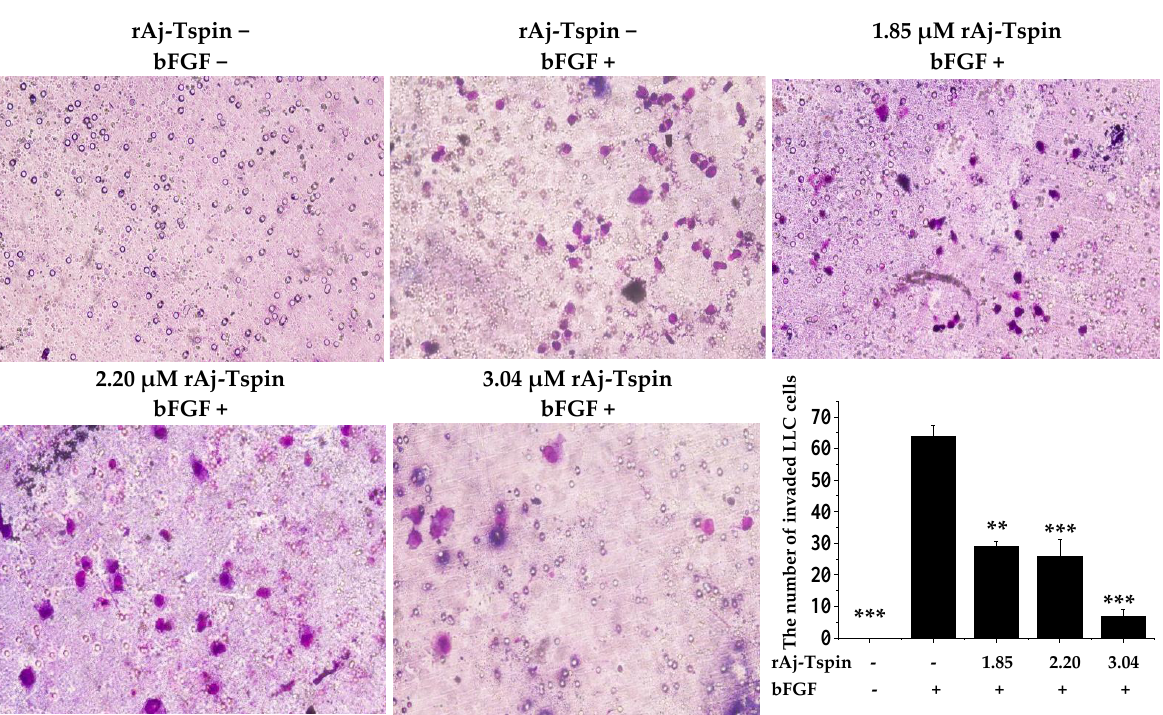
Figure 11. rAj-Tspin inhibited the invasion of LLC cells (OLYMPUS optical microscopy, 200×). ** and ***, respectively, indicate p < 0.01 and p < 0.001 (compared with the empty-medium and bFGF treatment groups).